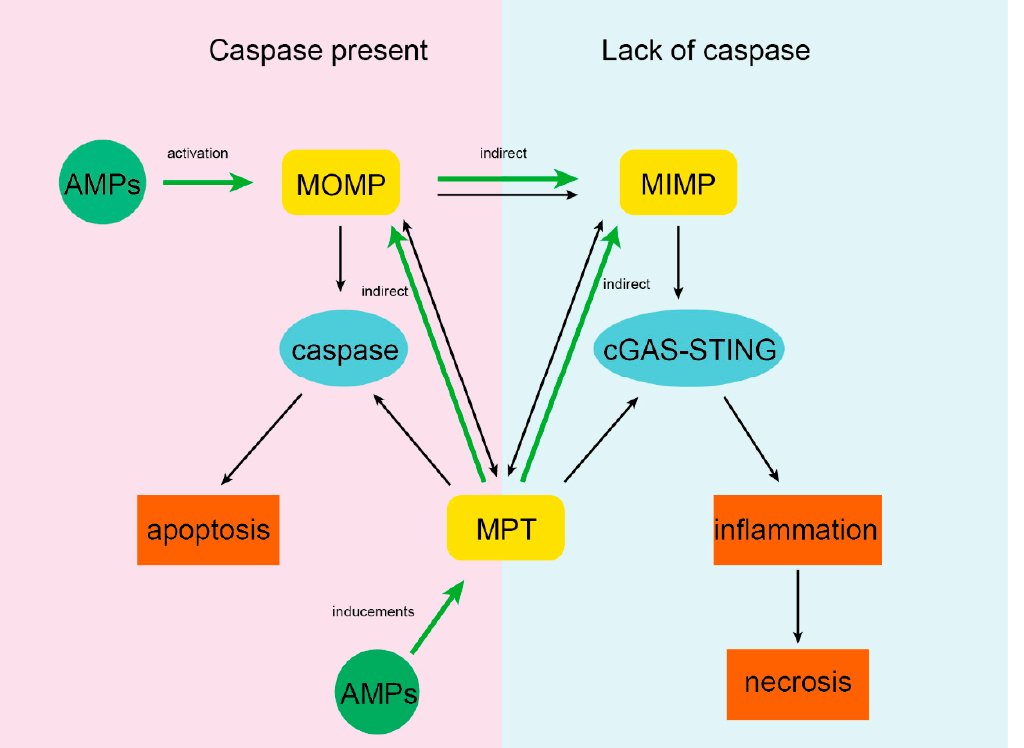
Figure 3. Effects of AMPs on MOMP, MIMP, and MPT . On the one hand, AMPs can induce MOMP and MPT directly. On the other hand, because MOMP, MIMP, and MPT are closely related, AMPs can indirectly induce MIMP. AMPs can trigger inflammation or apoptosis in cells by affecting MOMP, MIMP, or MPT and then indirectly affecting one or both processes.